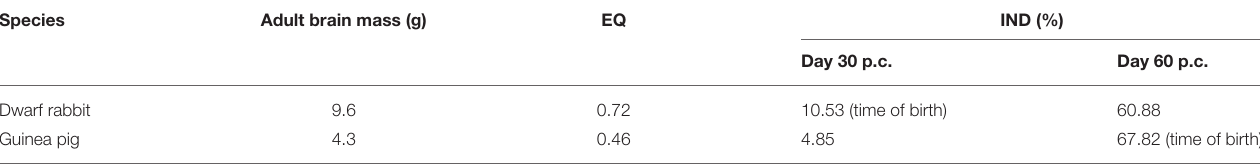
TABLE 1 | Adult brain mass, EQ, and IND of the dwarf rabbit and guinea pig. Species